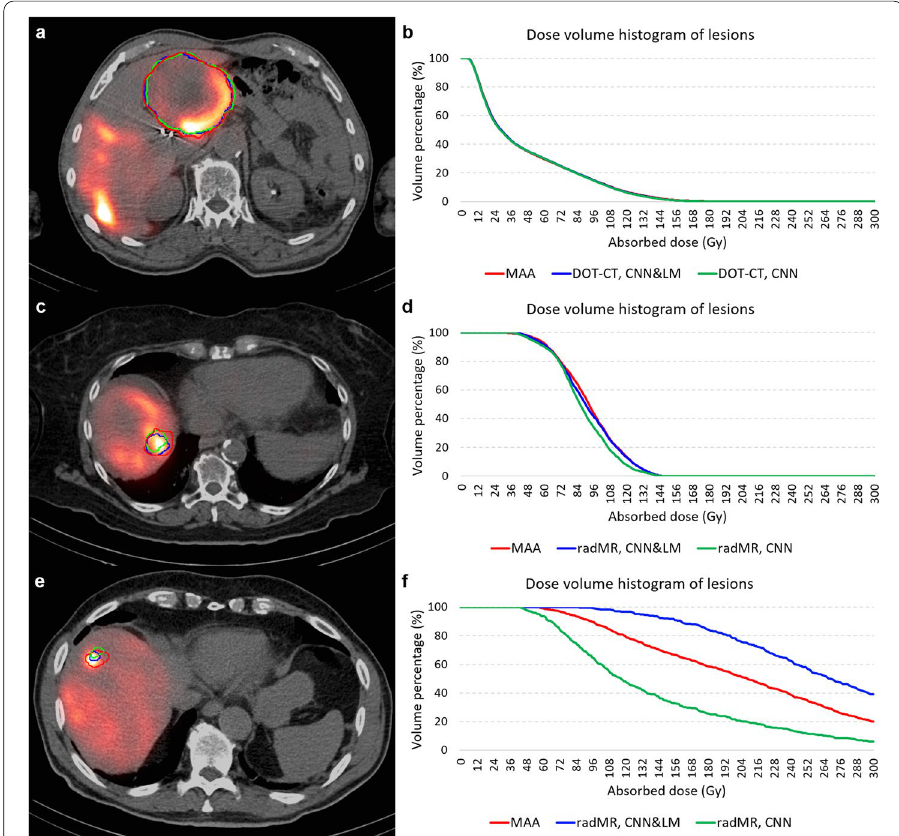
Fig. 13 Examples of the reference and floating lesions registered by the CNN&LM- and CNN-guided methods and their dose volume histograms from three patients. The red, blue, and green contours represent the reference lesion (MAA), the floating lesion registered by the CNN&LM-guided method (CNN&LM), and the floating lesion registered by the CNN-guided method (CNN). a , b the registered floating lesions from the CT of the DOTATATE (DOT) study; CNN&LM: score is 5, relative difference of mean dose is 0.1%, the − differences of V70 and V100 are 0.3% and 0.1%, CNN: score is 5, relative difference of mean dose is 0.9%, − − the differences of V70 and V100 are 0.2% and 0.4%. c , d the registered floating lesions from the radiology − MR (radMR); CNN&LM: score is 3, relative difference of mean dose is 1.3%, the differences of V70 and V100 − are 0.7% and 1.1%, CNN: score is 2, relative difference of mean dose is 5.2%, the differences of V70 − − − and V100 are 1.0% and 8.4%. e, f the registered floating lesions from radMR; CNN&LM: score is 3, relative − − difference of mean dose is 28.4%, the differences of V70 and V100 are 2.5% and 11.1%, CNN: score is 2, relative difference of mean dose is 32.5%, the differences of V70 and V100 are 11.1% and − − −